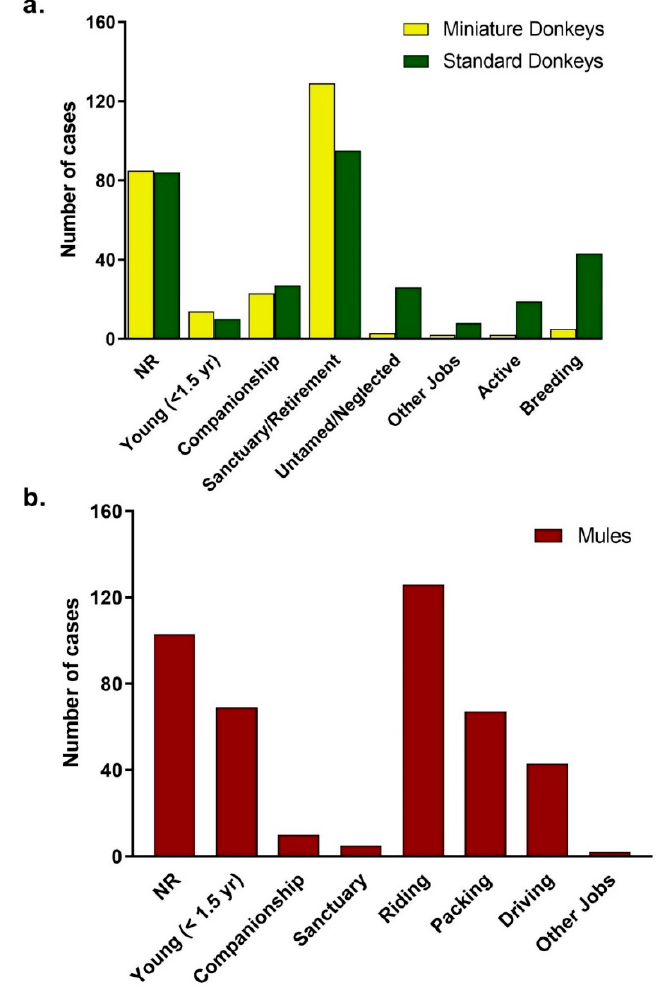
Figure 6. Distribution of Use for Donkey ( a ) and Mule ( b ) Caseload from 2008 to 2017. NR = Not reported in the medical record. Standard donkeys (green), miniature donkeys (yellow), and mules (red).